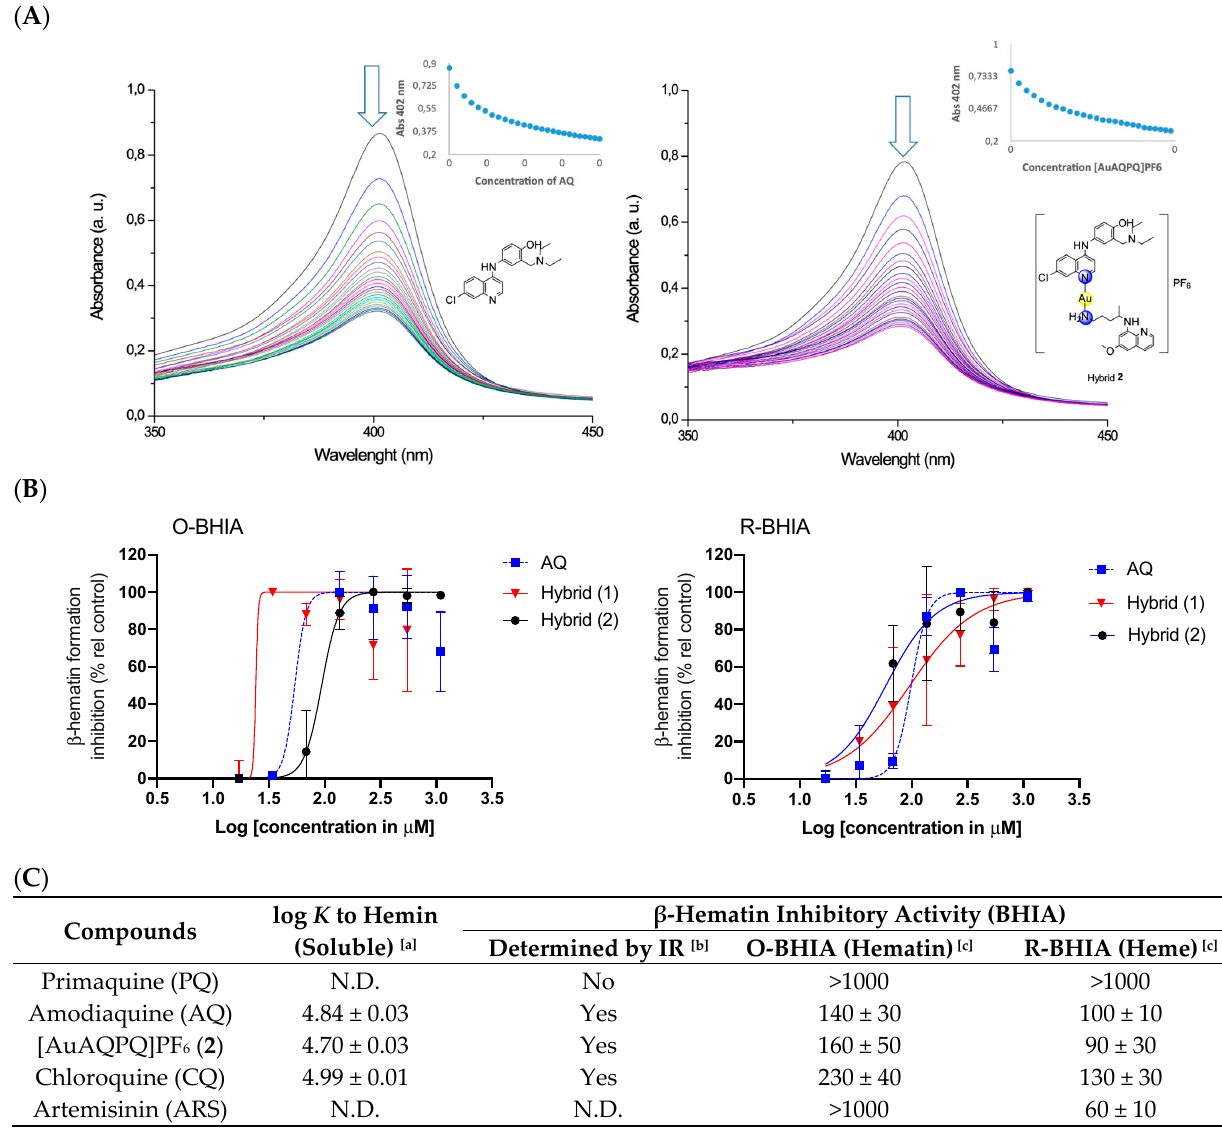
Figure 4. Effects of compounds on the suppression of heme detoxification as inferred by drug:hemin binding and inhibition of the β -hematin formation. Panel ( A ) Titration of ferriprotoporphyrin IX [Fe(III)-PPIX, hemin]. Panel ( B ) Inhibition of the β -hematin formation; dots are the median ± S.E.M and lines are the data fitted into the log(concentration) versus response with a variable slope equa- tion. Panel ( C ) Table summarizing the properties. Arrow in panel ( A ) indicates the decrease in ab- sorbance upon increasing concentration of compounds. Footnotes for table: [a] Association constant to [Fe(III)-PPIX]. Values are median ± S.E.M. of three independent experiments. [b] β -hematin for- mation upon incubation of a 3:1 ratio of drug:hematin for 30 min. and qualitatively determined by infrared (IR). Yes indicates β -hematin inhibition; No indicates β -hematin formation. [c] β -hematin formation determined after 18 h of incubation. Values are median ± S.E.M. of IC 50 μ M from three independent experiments. O-BHIA, oxidizing BHIA using hematin as reactant; R-BHIA, reducing BHIA using heme as reactant; S.E.M., standard error of the mean; AQ, amodiaquine (free base); PQ, primaquine (free base); CQ, chloroquine (free base); ARS, artemisinin; N.D., not determined.